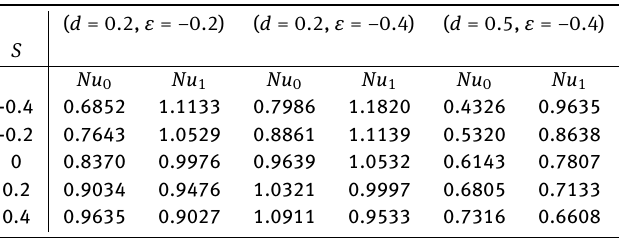
Table 4: Rate of heat transfer at the heated plate y = 0 and cold plate y = 1 for different values of S , d and ε where Br = 0.2 , Gre = 10 , q = 1 and λ = −0.2 ( d = 0.2 , ε = −0.2 )